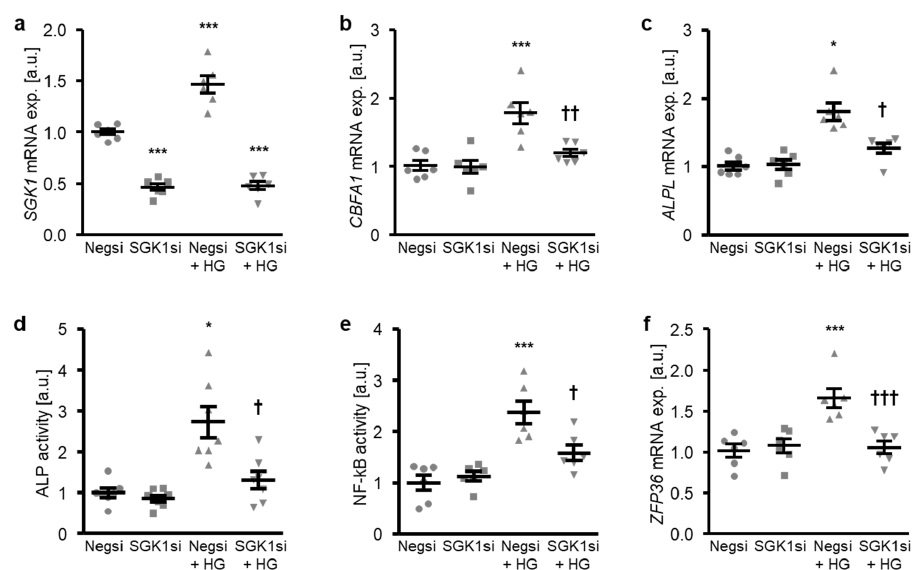
Figure 4. Silencing of SGK1 inhibits high glucose-induced osteogenic signaling in HAoSMCs. ( a – c ) Scatter dot plots and arithmetic means ± SEM ( n = 6; arbitrary units, a.u.) of the SGK1 ( a ), CBFA1 ( b ), and ALPL ( c ) relative mRNA expression in HAoSMCs following transfection with negative control siRNA (Negsi) or SGK1 siRNA (SGK1si) and treatment with control or 50 mM of glucose (HG). ( d ) Scatter dot plots and arithmetic means ± SEM ( n = 7, a.u.) of the ALP activity in HAoSMCs following transfection with negative control siRNA (Negsi) or SGK1 siRNA (SGK1si) and treatment with control or 50 mM of glucose (HG). ( e ) Scatter dot plots and arithmetic means ± SEM ( n = 6; a.u.) of the NF- κ B-dependent transcriptional activity in HAoSMCs following transfection with negative control siRNA (Negsi) or SGK1 siRNA (SGK1si) and treatment with control or 50 mM of glucose (HG). ( f ) Scatter dot plots and arithmetic means ± SEM ( n = 6; a.u.) of the ZFP36 relative mRNA expression in HAoSMCs following transfection with negative control siRNA (Negsi) or SGK1 siRNA (SGK1si) and treatment with control or 50 mM of glucose (HG). * p < 0.05, *** p < 0.001 significant vs. Negsi-transfected HAoSMCs; † p < 0.05, †† p < 0.01, ††† p < 0.001 significant vs. Negsi-transfected and HG-treated HAoSMCs.